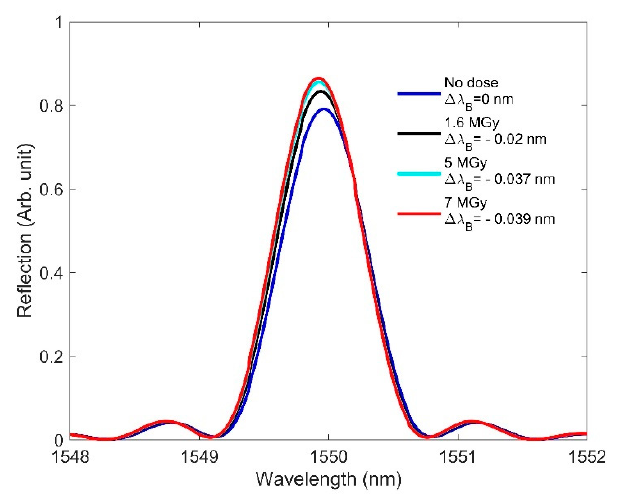
Figure 12. RIC effects on FBG at high doses: blueshift of 0.039 nm in the Bragg wavelength when the dose is increased from 0 to 7 MGy and radiation-induced changes in length and RI are considered.